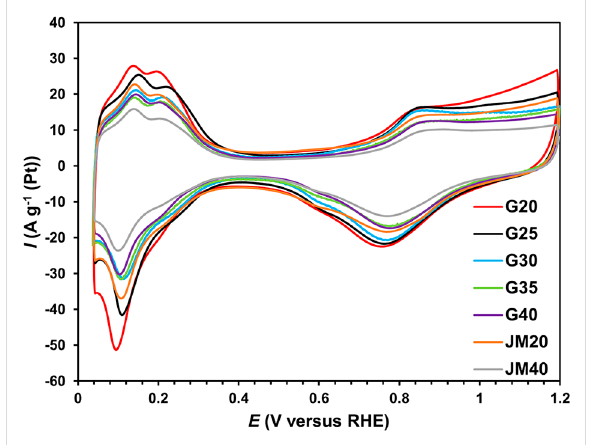
Figure 4: Cyclic voltammograms of Pt/C samples. Sweep rate of 20 mV·s − 1 , 2nd cycle. Electrolyte used: 0.1 M HClO 4 solution satu- rated with Ar at atmospheric